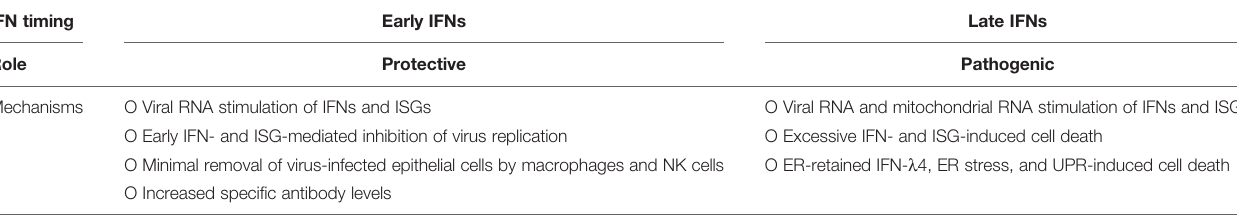
TABLE 1 | Protective early IFNs and late pathogenic IFNs in severe